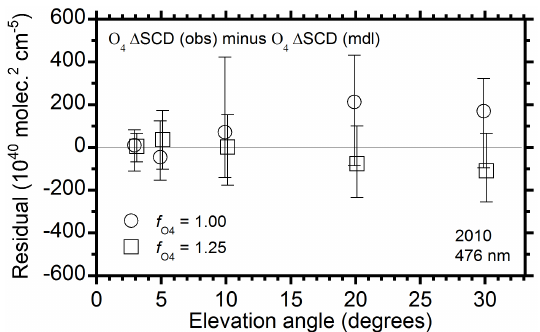
Figure 8. Median values of residuals, O 4 (cid:49) SCD (obs) minus O 4 (cid:49) SCD (mdl), as a function of elevation angle. Values for retrievals with f O =1.00 and f O =1.25 are plotted with circles and squares, 4 4 respectively. Error bars represent 67% ranges. Figure 9. Individual profile retrieval residuals, O 4 (cid:49) SCD (obs) mi-